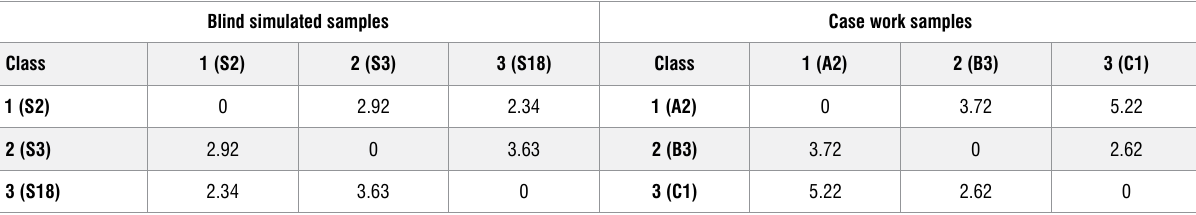
Matrices showing distances between central objects at t=72 h for the simulated nyaope samples S2, S3 and S18 and casework samples A2, B3 and C1 Blind simulated